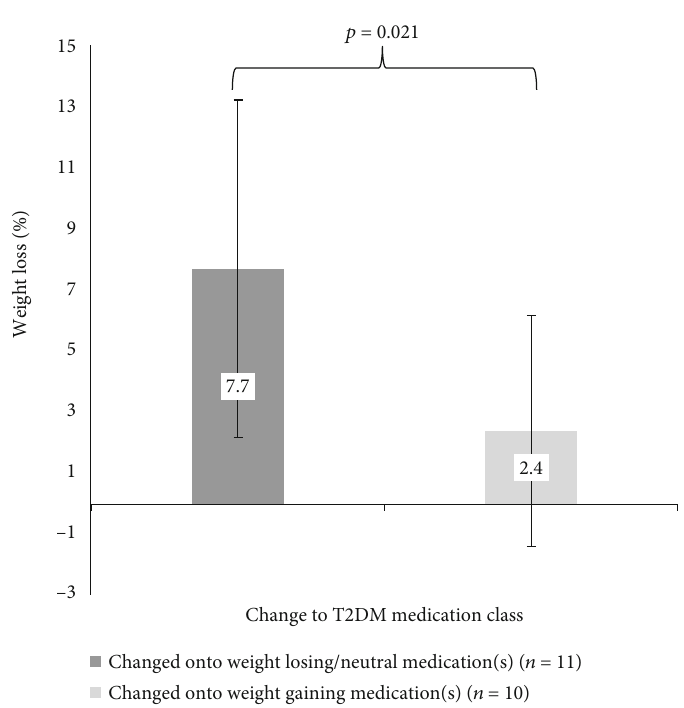
Figure 3: Change to diabetes medication class and weight loss at 6 months for T2DM